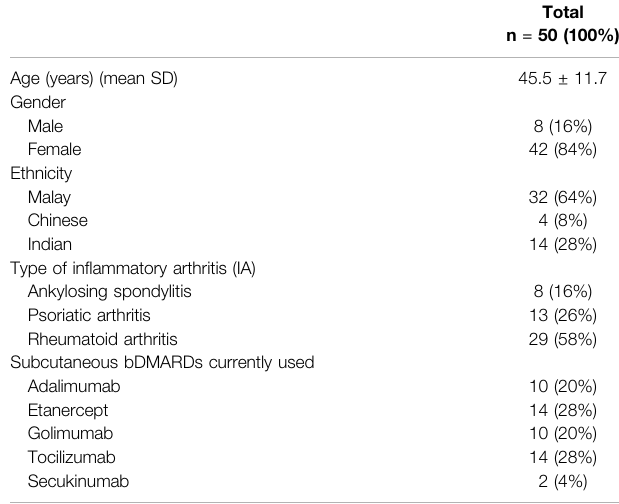
TABLE 2 | Demographic pro fi le of sample population for